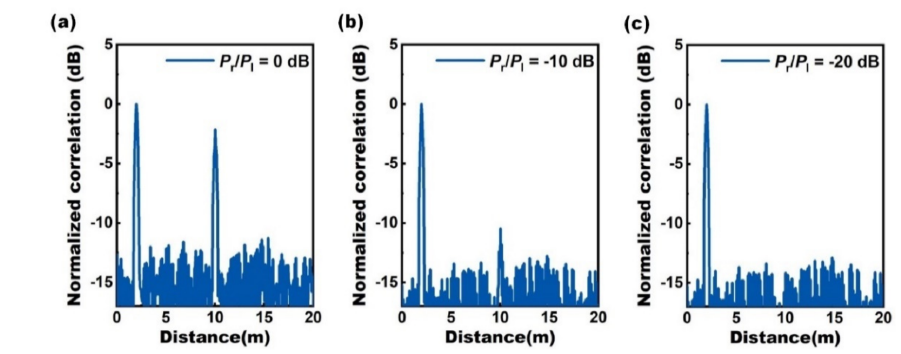
Figure 5. Numeric simulations for the coherent RMCW LiDAR in presence of internal reflection. The internal reflection is at 2 m, while the target is at 10 m. The power of the internal reflection is 1.5 nW. The power of the backscattered signal is ( a ) 1.5 nW, ( b ) 0.15 nW and ( c ) 0.015